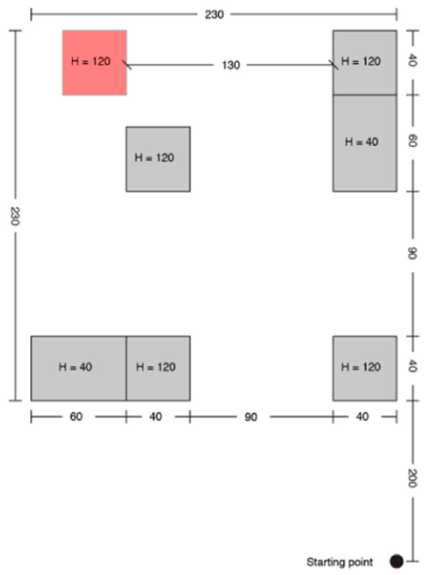
Figure 5. Treasure hunt (TH) configuration A.